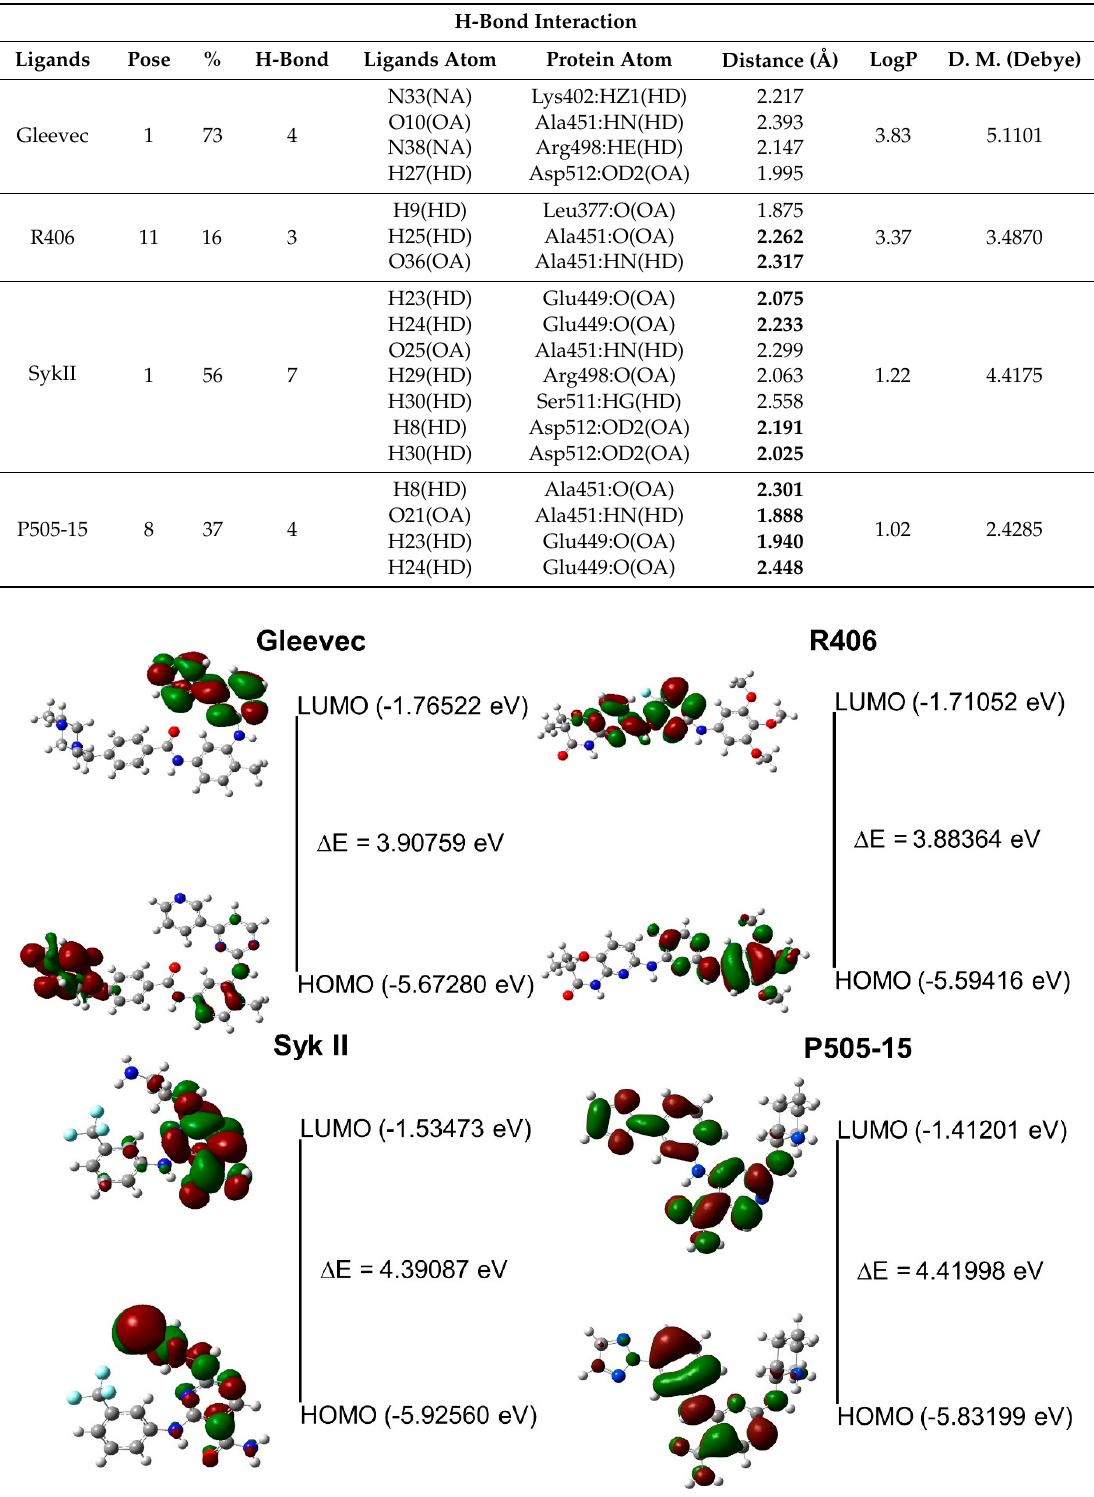
Table 3. The data shown represent the H-bond binding found in docking analyses from the di ff erent inhibitors (Gleevec, R406, Syk II, and P505-15) interacting with Syk protein. Abbreviations: hydrogen donor, HD; oxygen acceptor, OA; nitrogen acceptor, NA; Debie, D; and Angstrom, Å. The cross-bridge H-bond interactions with the same aa are listed in bold”.